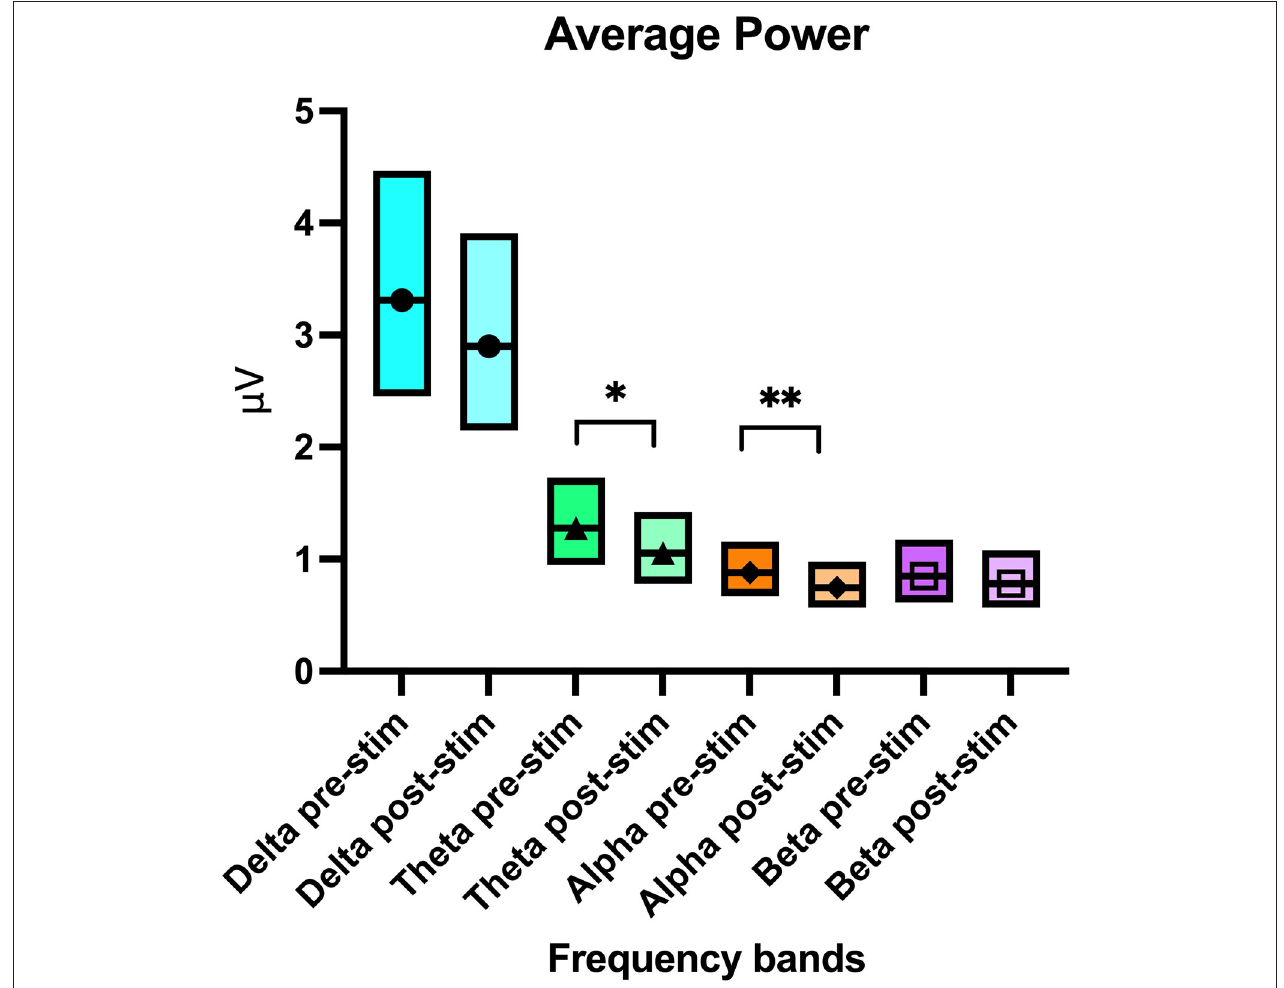
FIGURE 6 | Boxplot graph showing the average power per channel per frequency band with the upper and lower confidence intervals before and after stimulation. The line crossing the boxes indicate the median value obtained in that frequency band. An * denotes statistical significance of p = 0.02 and ** denotes a significance of p =